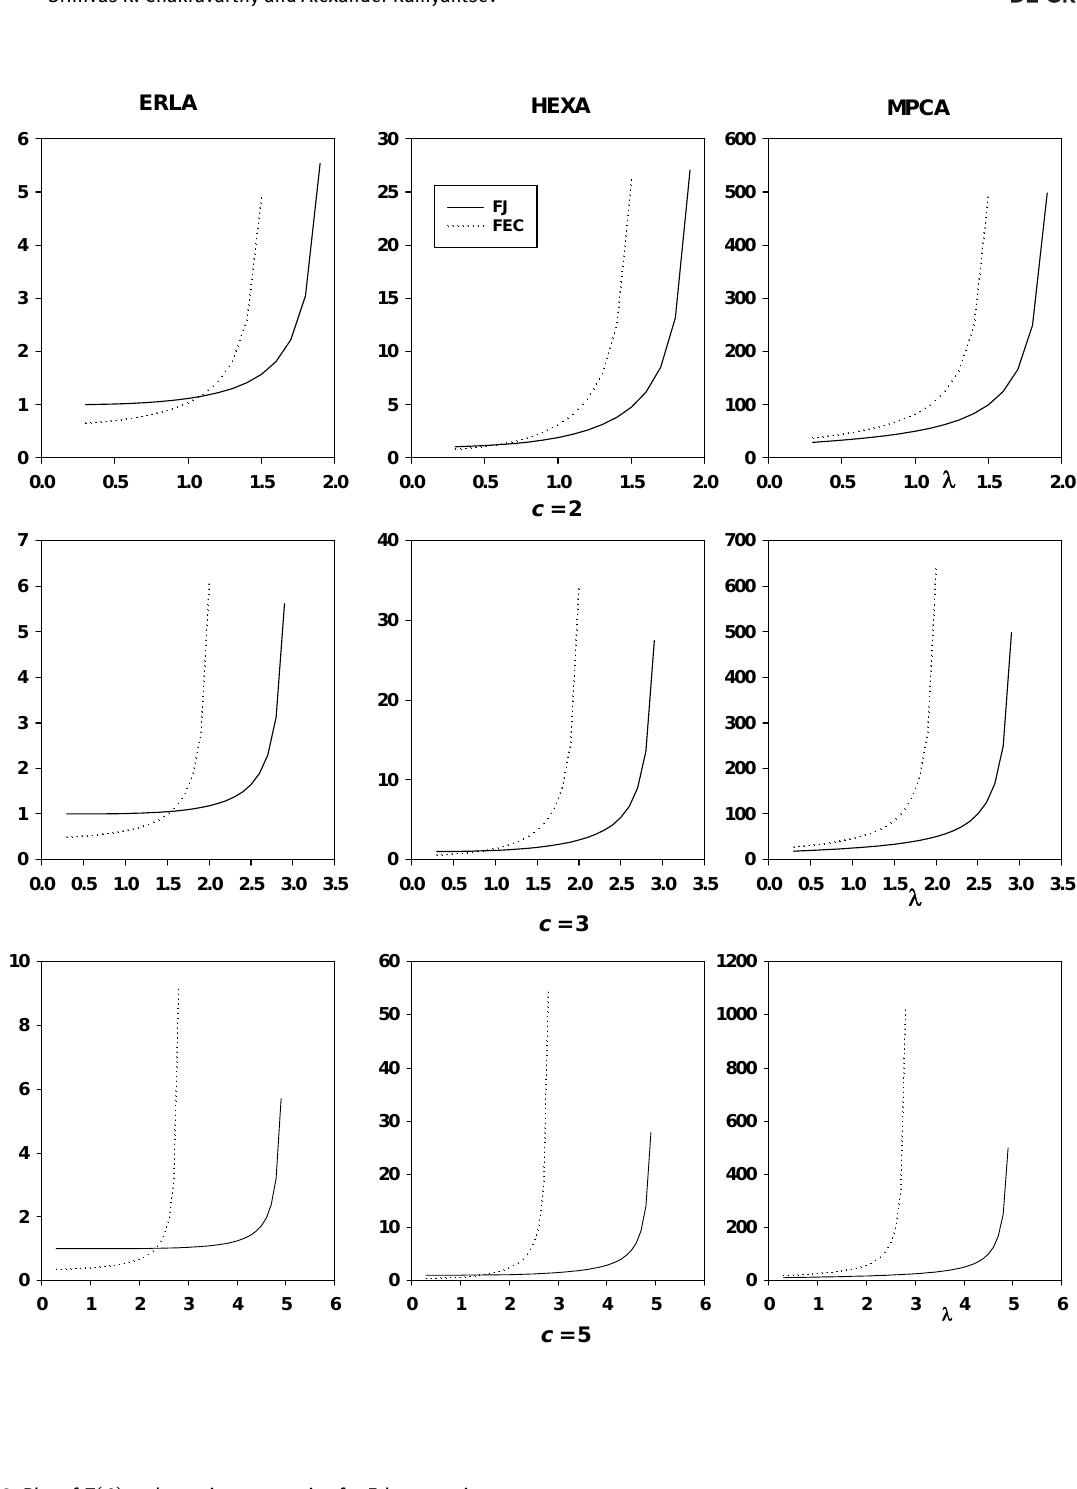
Figure 3: Plot of E ( L ) under various scenarios for Erlang